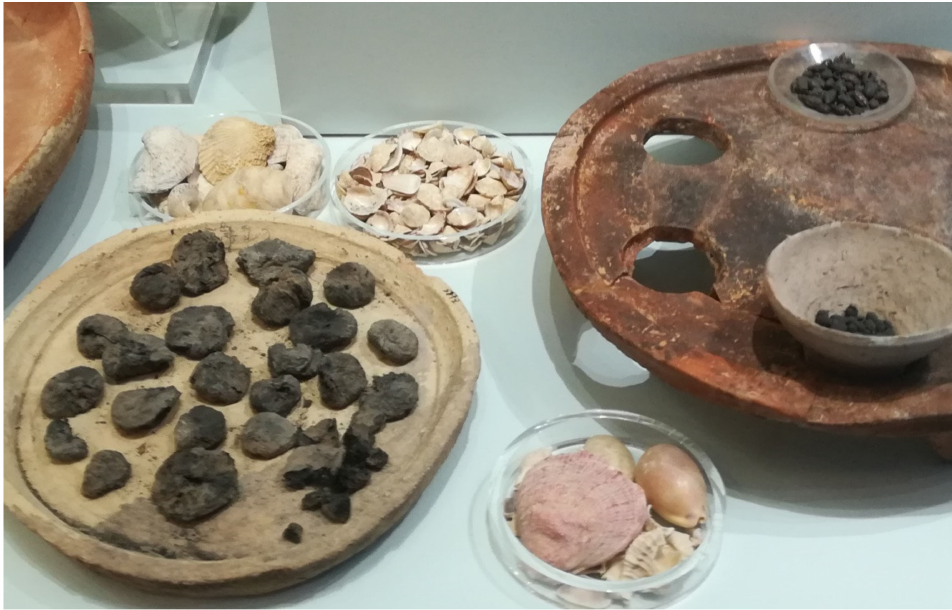
Figure 7. Carbonized Cretan figs, olives, and diverse shellfish, about 1500–1600 BC, Hagia Triada site, Heraklion Archaeological